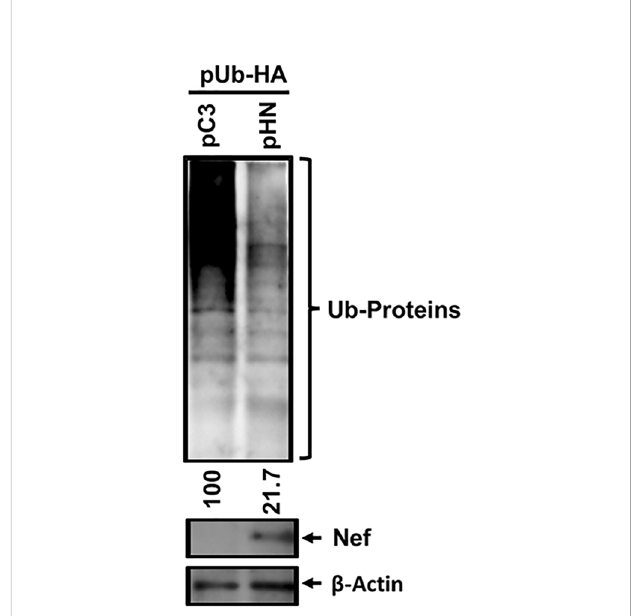
FIGURE 1 Effect of HIV-1 Nef on overall ubiquitination of cellular proteins. The indicated plasmids, pUb-HA and pHN-Myc.His (pHN) or pCDNA3.1 ( − )-Myc.His (pC3), were transfected into 293T cells, and 3 days post- transfection, WB analysis was executed with the cell lysates generated from the transfected cells to detect the indicated proteins. The relative intensity of the ubiquitinated cellular proteins (Ub-Proteins) in the presence (47.6) compared with the absence of Nef (100) was determined based on normalization of b -Actin, using Bio-Rad image analysis